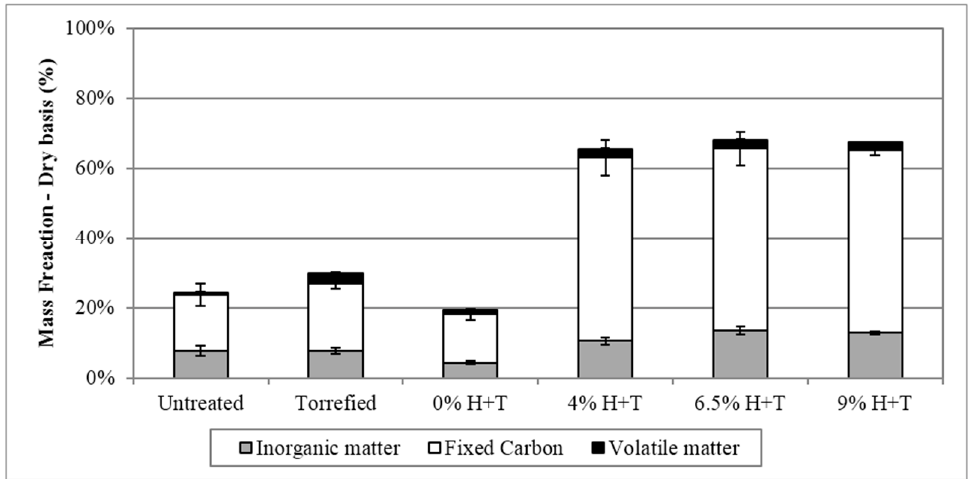
Figure 5. Proximate analysis mass fractions and yield of biochar produced from fast pyrolysis of pretreated phragmites.